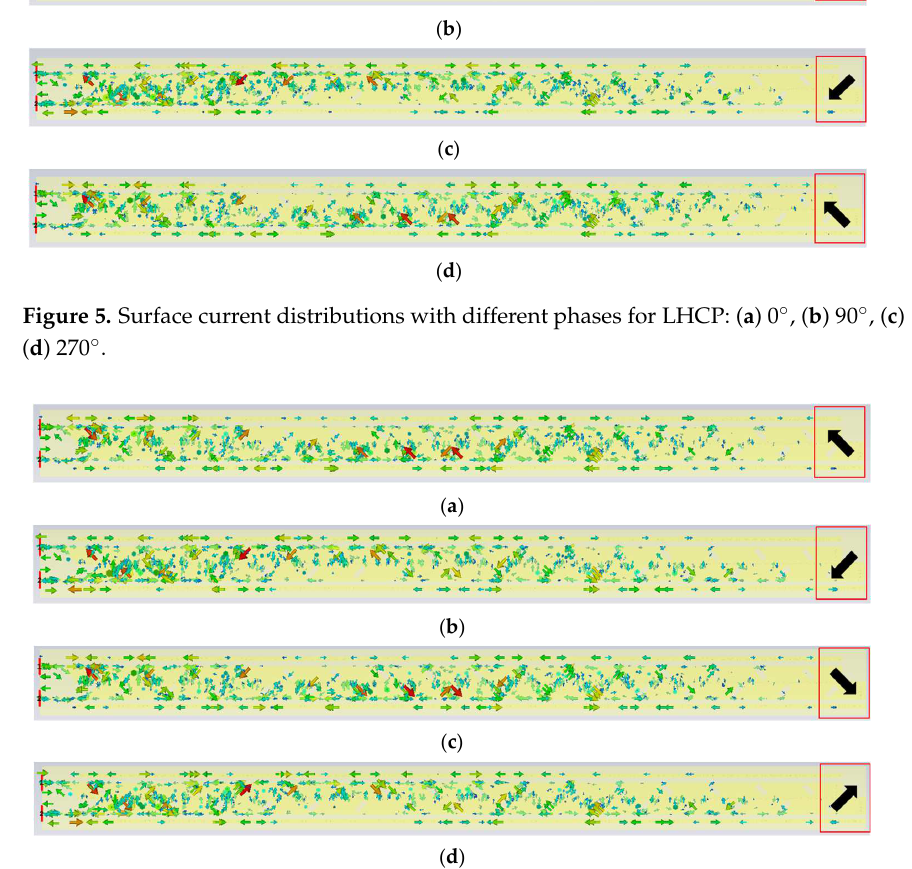
Figure 6. Surface current distributions with different phases for RHCP: ( a ) 0°, ( b ) 90°, ( c ) 180°, and ( d ) 270°.